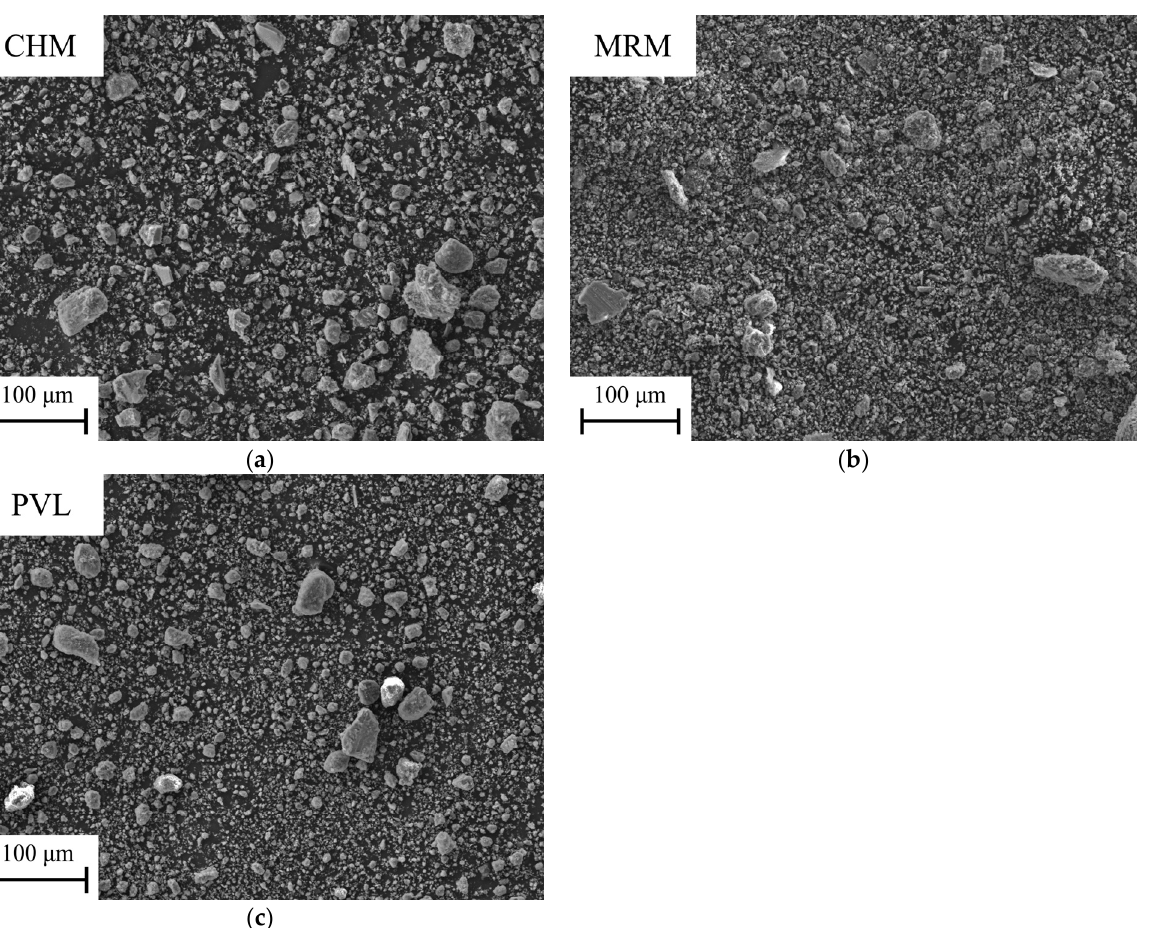
Figure 5. Selected SEM micrographs (×500) of: ( a ) CHM powder; ( b ) MRM powder; ( c ) PVL powder. Table 4. EDS microanalysis (wt %) of the areas marked in Figure 5a (CHM powder).